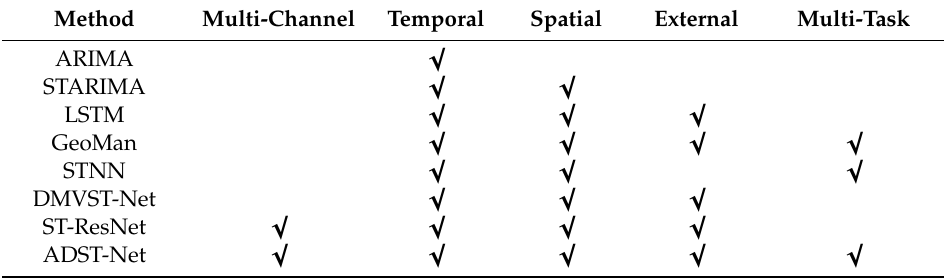
Table 4. Baseline Component